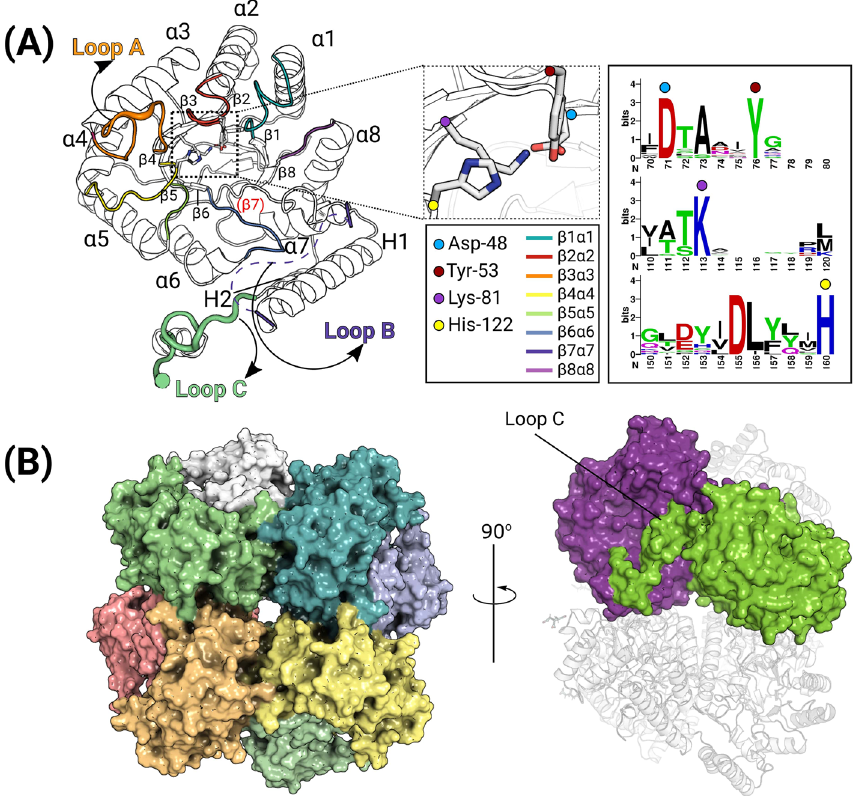
Figure 3. Crystal structure of DepB Rleg protomer and octameric assembly. ( A ) Cartoon representation of the protomer with a view looking down the top of the TIM barrel rendered in black and white with the β7 annotated in red. Loop A (orange) caps the top of the substrate-binding cleft, loop B (dashes) could not be modeled but its position has been highlighted in this figure, and finally, loop C (green) which extends into the active site of the opposing protomer in the dimer. A sequence logo highlighting the conservation of the catalytic residues has also been provided. ( B ) Surface and cartoon rendition of the DepB Rleg octamer. This assembly was predicted using the PISA server. View rotated at a 90° angle depicting 3D domain swapping of loop C at the dimer